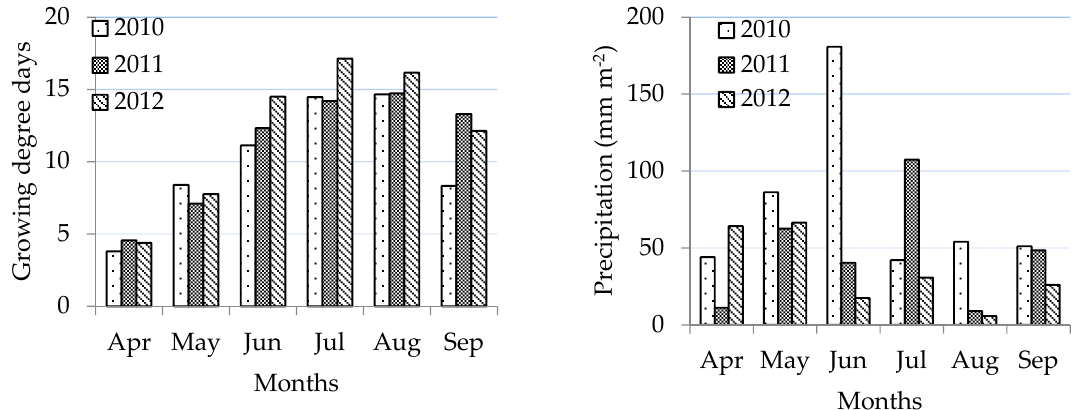
Figure 1. Air temperatures presented in growing degree days ( left ) and precipitation totals ( right ) in Zemun Polje for 2010–2012 growing period.